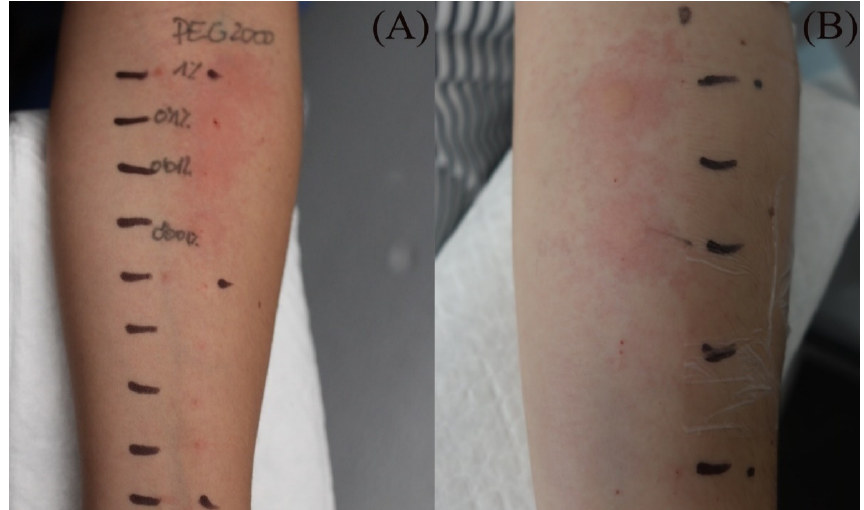
Figure 1. Skin testing: results for polyethylene glycol. ( A ) Intradermal testing (IDT) of PEG-2000 with positivity for all concentrations with significant papules and erythema at 20 min. ( B ) IDT of PEG-2000 with positivity for PEG-2000 1%, 0.1%, and 0.01% at 2 h.